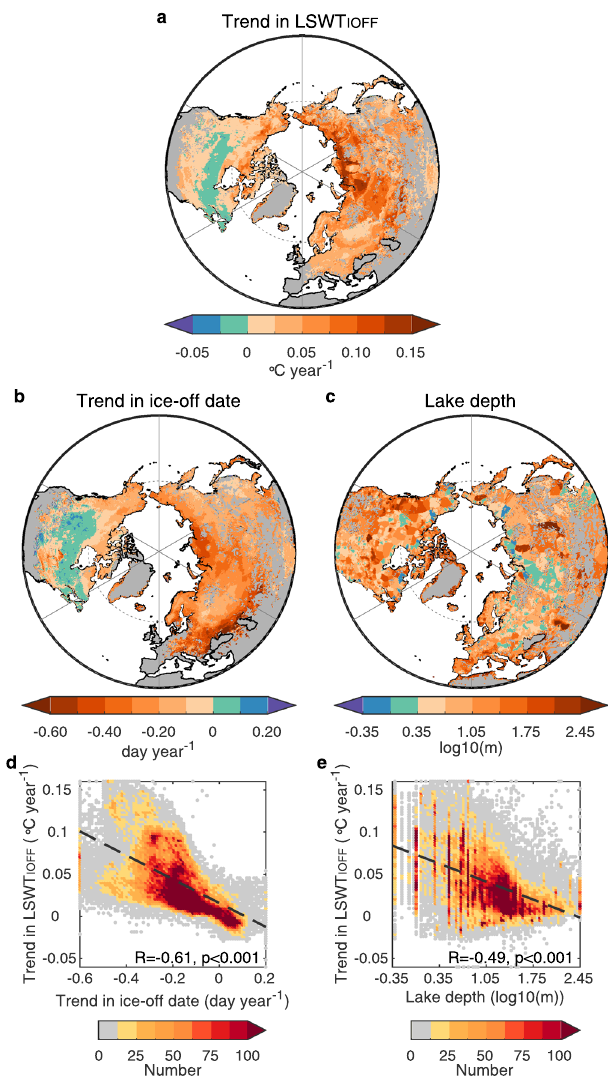
Fig. 2 |Explanationforexcesswarming intheice-offmonth.a – c Spatialpattern of the trend in LSWT IOFF ( a ), ice-off date ( b ) and lake depth ( c ). d , e Relationship between the trend in LSWT IOFF ( y -axis) and the trend in ice-off date ( d ) and lake depth ( e ) ( x -axis). The colour of points in d , e shows the number of